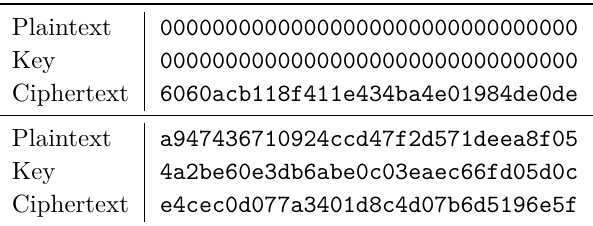
Table 20: Test vectors for Orthros in